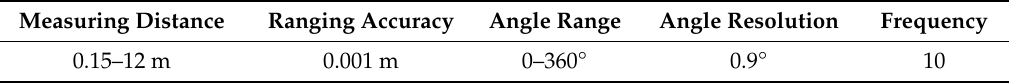
Table 1. The key parameters of